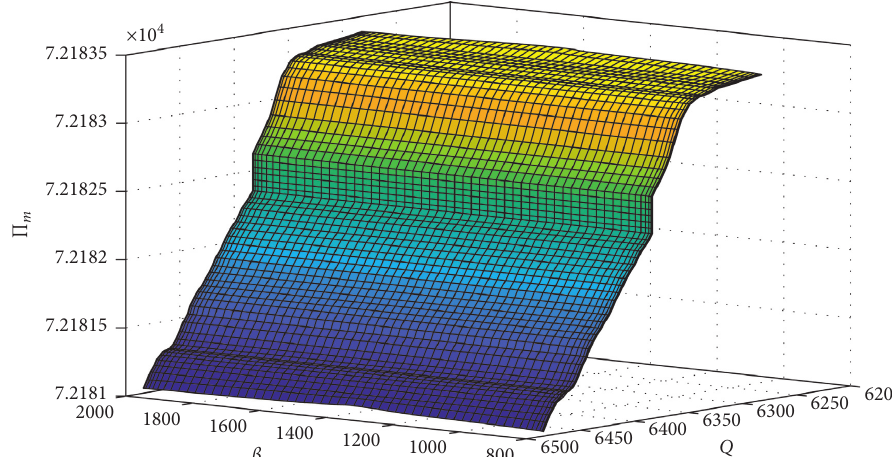
Figure 4: The impact of carbon emission reduction cost factors and order quantities on manufacturers’ revenues under centralized decision-